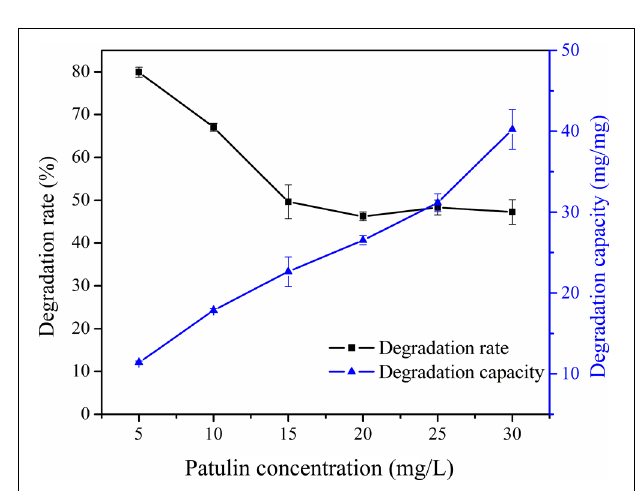
FIGURE 3 | Effect of pH on degradation rate and degradation capacity of PPL for patulin.